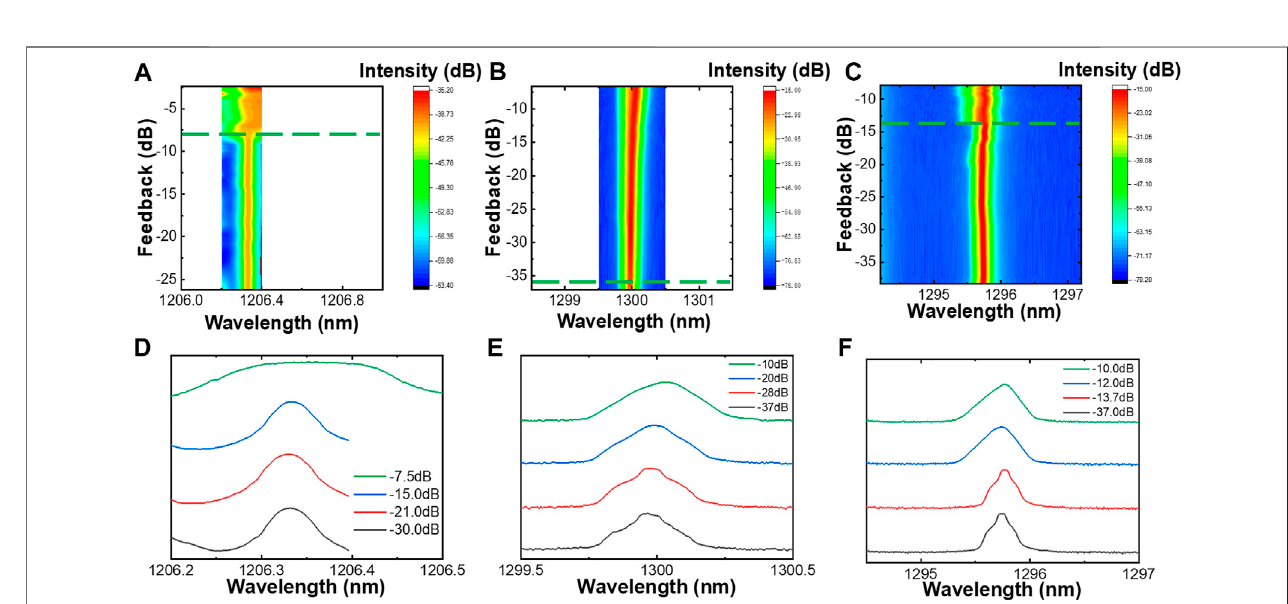
FIGURE 3 | The evolution of optical spectra of (A,D) the QD FP laser; (B,E) QW FP laser; and (C,F) QW DFB laser.